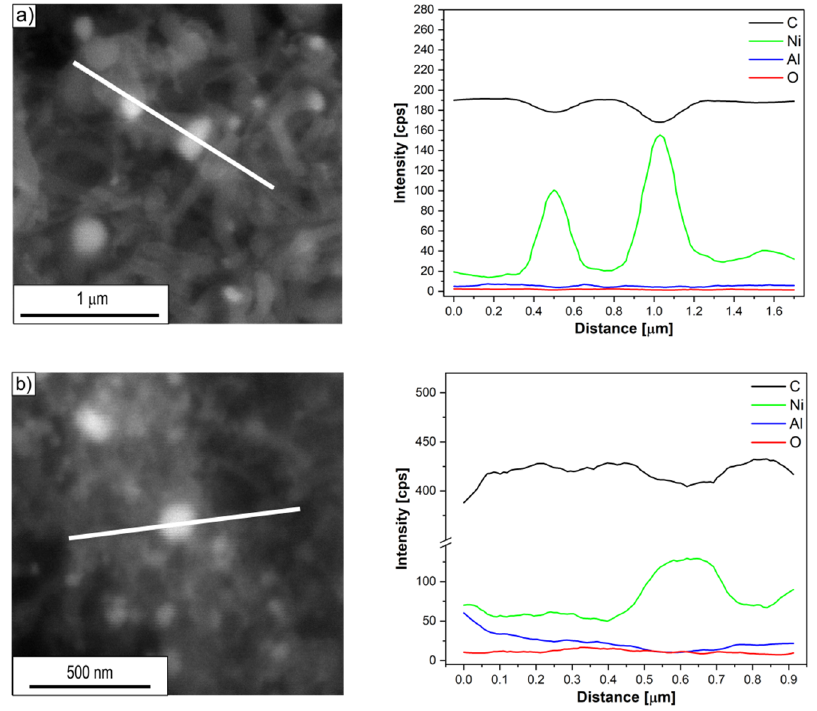
Figure 5. Linear EDS/SEM analysis of the CNT/CNF area with nickel-like nanoparticles formed after decomposition of ethanol without water vapour addition (mixture #1) at: ( a ) 500 and ( b ) 700 ° C.